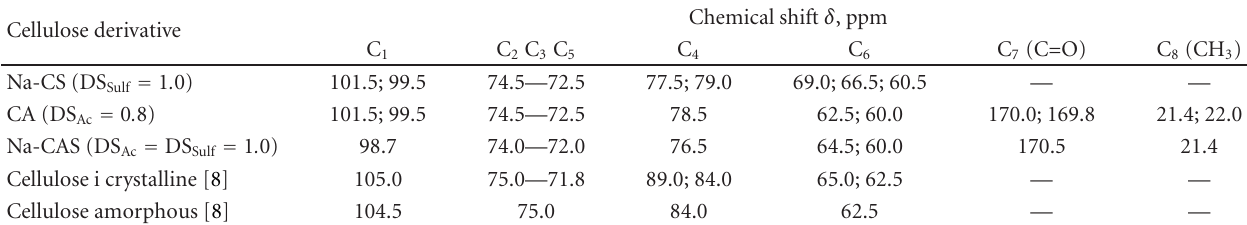
Cellulose amorphous